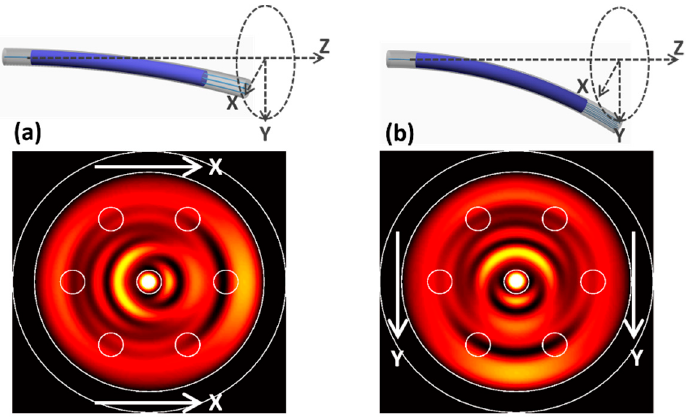
Figure 3. MMI image distortion induced by fiber bend in the ( a ) X and ( b ) Y direction .